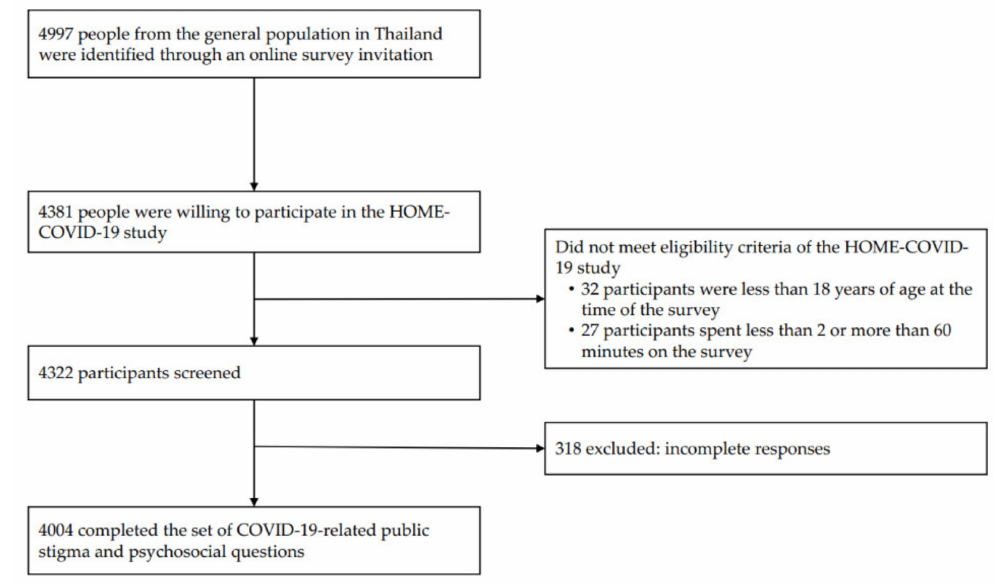
Figure 1. Flow diagram for study participants. Abbreviation: HOME-COVID-19, The Health Outcomes and Mental Health Care Evaluation Survey Research Group-Coronavirus disease